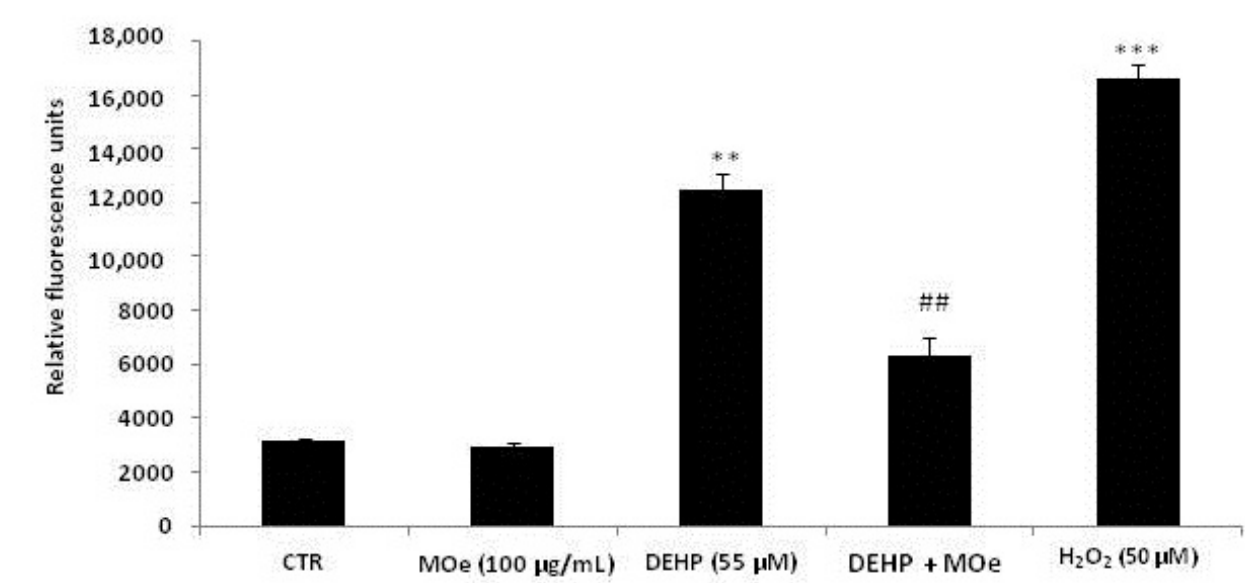
Figure 4. Effect of MOe on DEHP-induced reactive oxygen species (ROS) generation. SH-SY5Y cells were pretreated with MOe (100 µ g/mL) for 2 h before DEHP treatment for 24 h (55 µ M) or with H 2 O 2 (20 µ M) as a positive control. The relative intracellular ROS production was assessed by measuring the fluorescence of DCF, resulting from the oxidation of DCFH mainly by H 2 O 2 . Data are expressed as the mean ± SD of three separate experiments. ** p < 0.01 vs. control and ## p < 0.01 vs. DEHP alone, *** p < 0.001 vs. control.